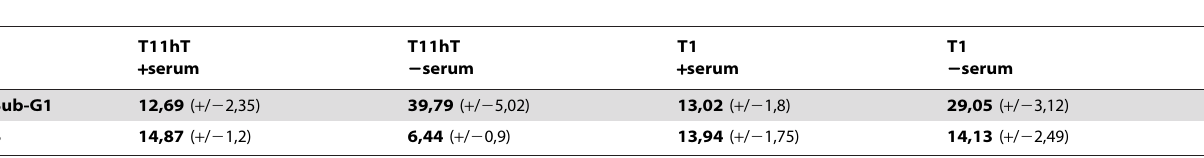
Table 1. Mean values (and standard deviations in parentheses) relative to the flow cytometry analysis described in Figure